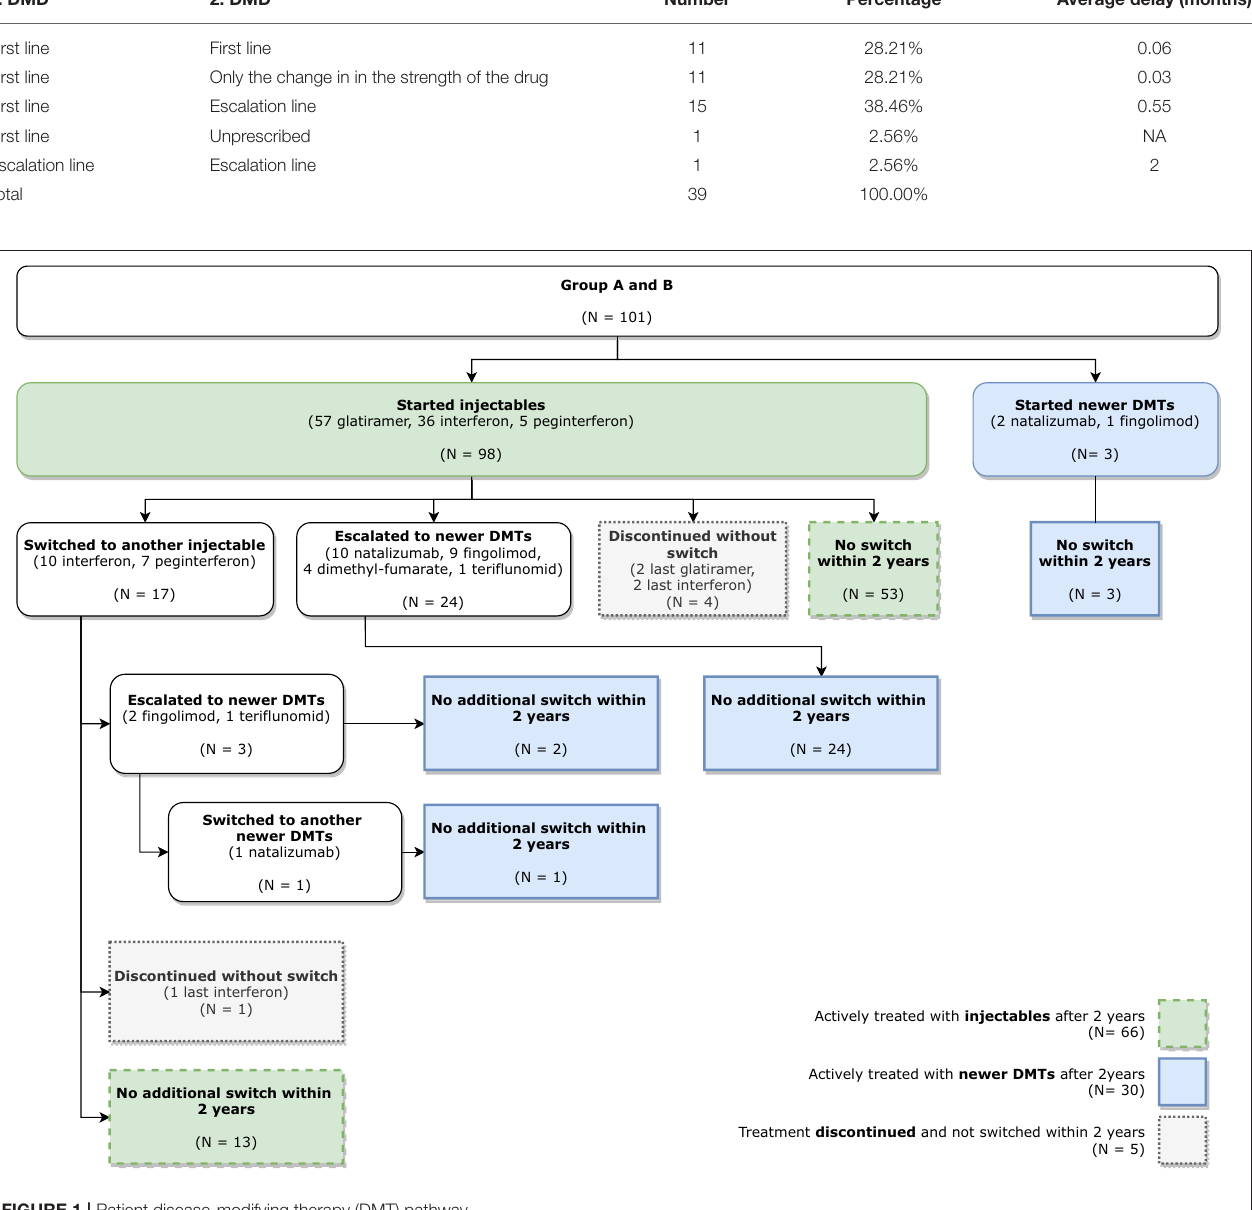
FIGURE 1 | Patient disease-modifying therapy (DMT)